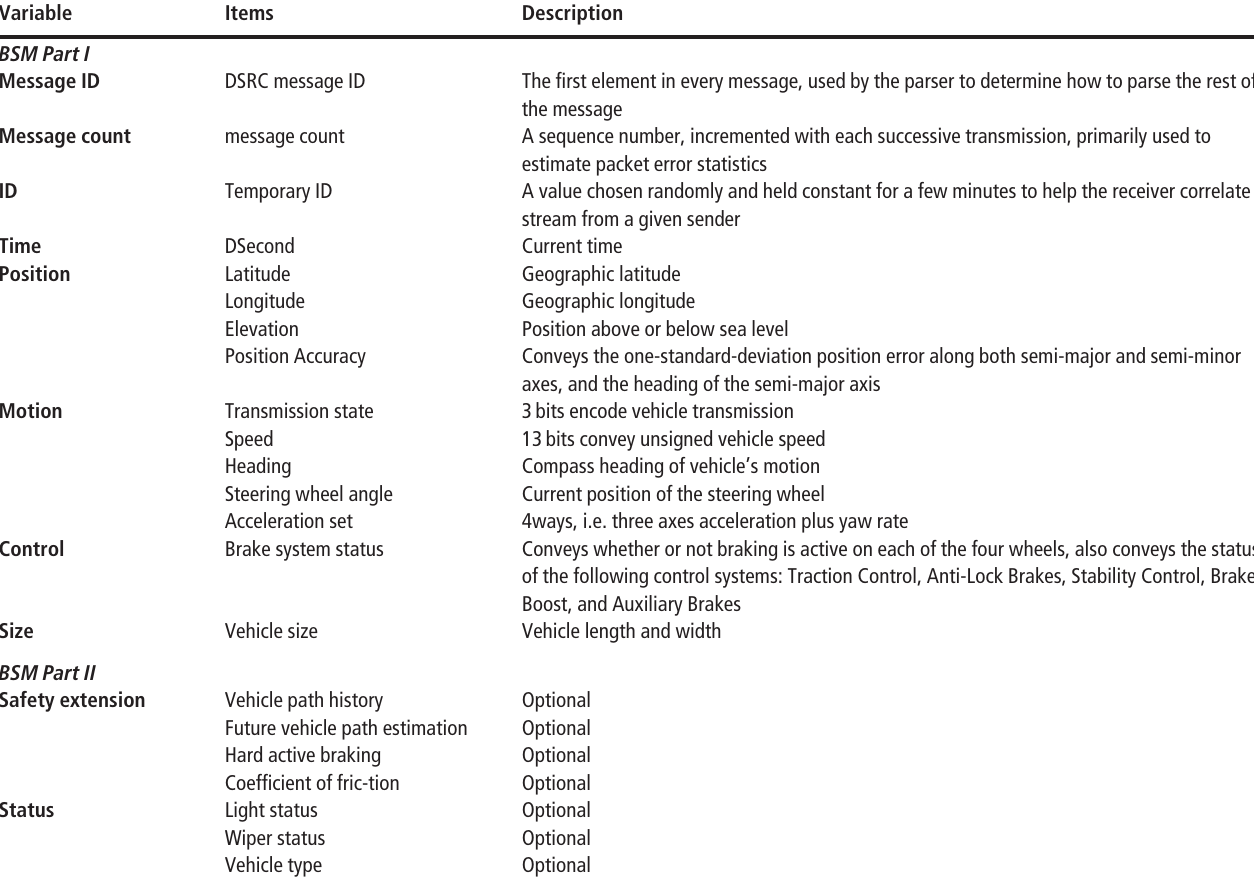
Table I SAE J2735 Basic safety